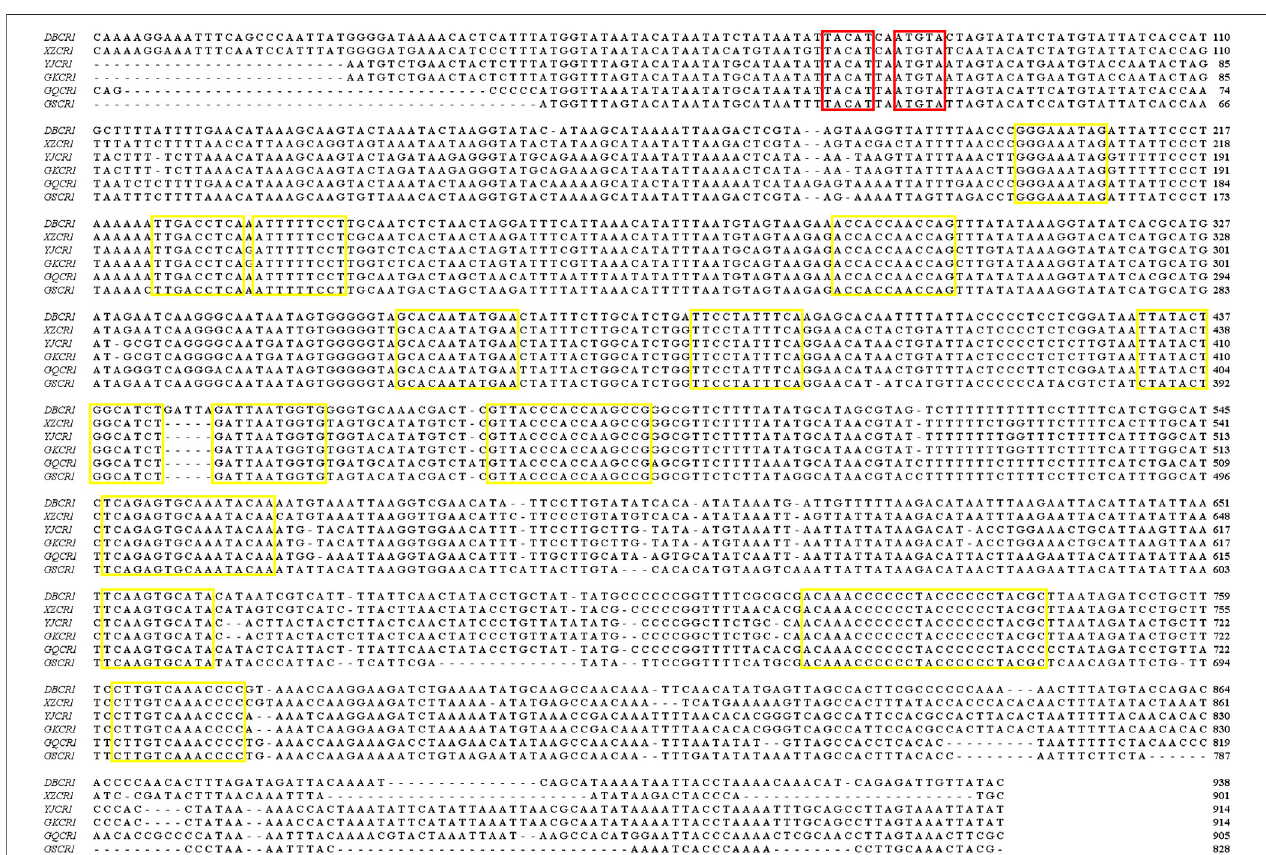
FIGURE 4 | Compositional features of the fi rst control region of the rearranged Garra mitochondrial genome. Palindromic motif sequences “ TACAT ” and “ ATGTA ” are marked in red boxes. Conservative sequences are marked using yellow boxes. DBCR1 : The fi rst control region of Garra dengba. XZCR1 : The fi rst control region of Garratibetana.YJCR1 :The fi rstcontrolregionof Garrayajiangensis.GKCR1 :The fi rstcontrolregionof Garrakempi . GQCR1 :The fi rstcontrolregionof Garraqiaojiensis. GSCR1 : The fi rst control region of Garra salweenica .